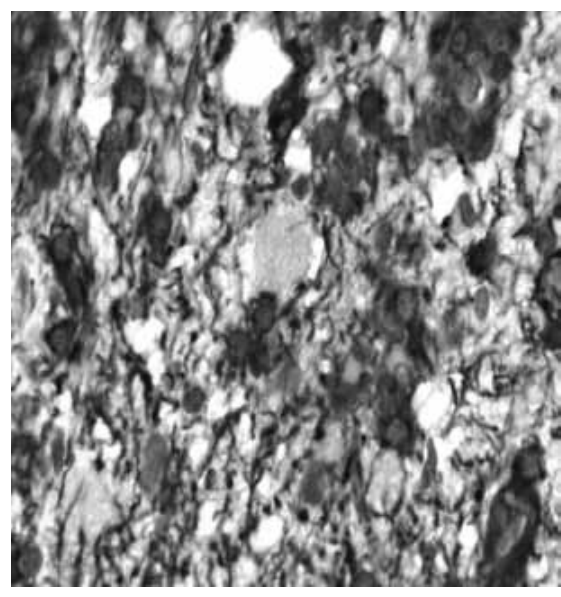
figurE 8 – Eosinophilic granular body negative for GFAP immunostaining in the center of the image (lens 40×) GFAP: glial fibrillary acidic protein. figurE 7 – Eosinophilic granular body immunostained with SYN in pleomorphic xanthoastrocytoma (lens 40×) SYN: synaptophysin. tABLE 3 – Morphological and radiological characteristics as well as tumor progression analyzed in PAs with or without ganglion component, PXA and GG expressed in absolute numbers and percentages (in parenthesis) for each group PA without ganglion component